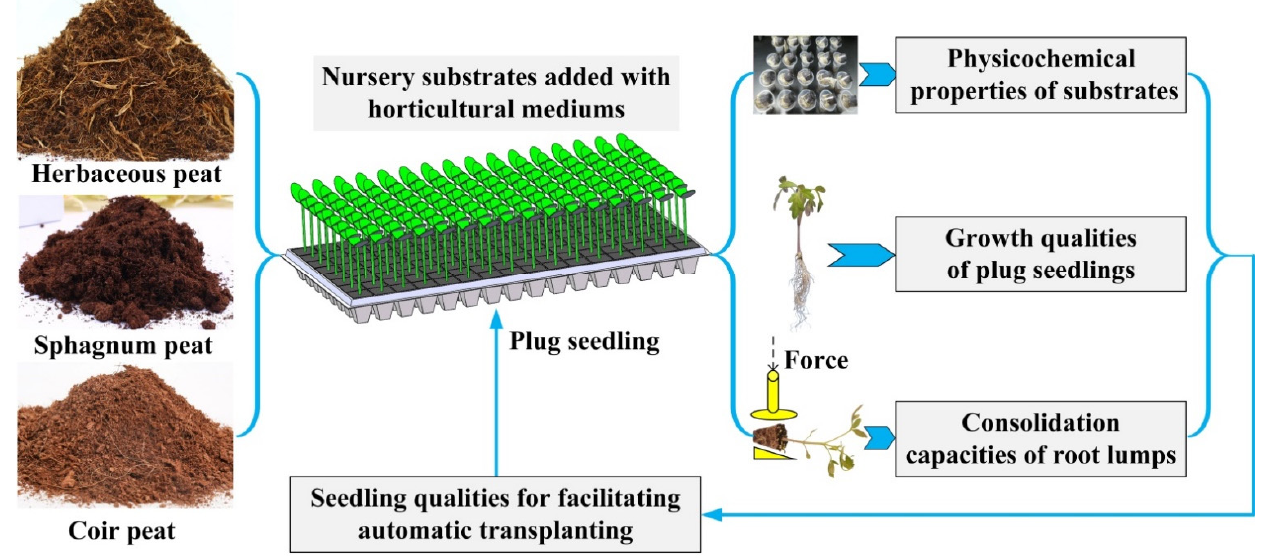
Figure 1. The overall technology route of studying the seedling effects of the nursery substrates added with three horticultural mediums.